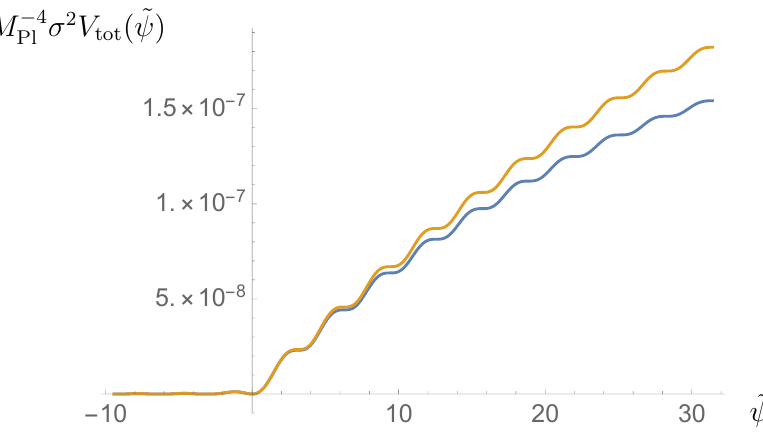
Figure 4 . The shift K K tot changes the potential from the yellow to the blue curve. However, ! the maximum (cid:12)eld distance (cid:1) ~ max is not a(cid:11)ected by the change since it does not depend on K . The potentials are plotted here for g s M = 500 and K =